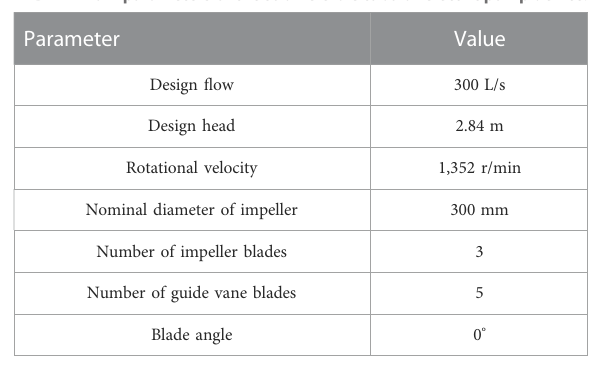
TABLE 1 Main parameters of the submersible tubular electric pump device.